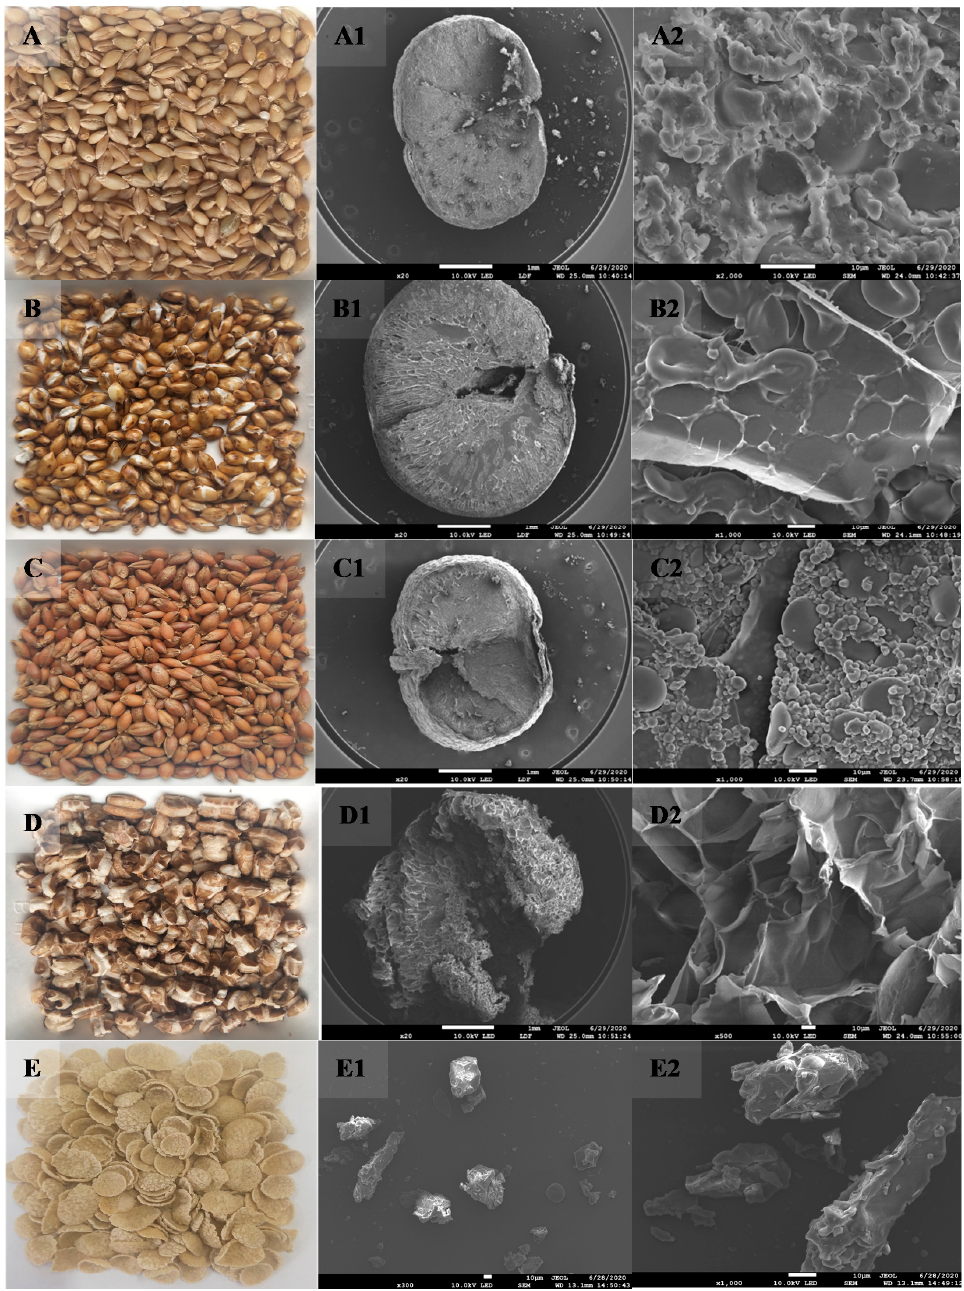
Figure 1 . SEM of highland barley after processing by different thermal treatments. ( A ): Untreated (CK); ( B ): Sand-roasting (SR); ( C ): Far-infrared Baking (FB); ( D ): Steam Explosion (SE); ( E ): Extrusion (EX).